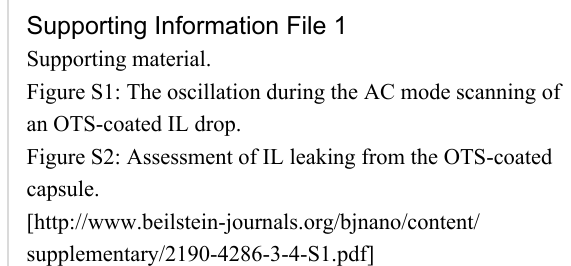
Figure S1: The oscillation during the AC mode scanning of an OTS-coated IL drop. Figure S2: Assessment of IL leaking from the OTS-coated